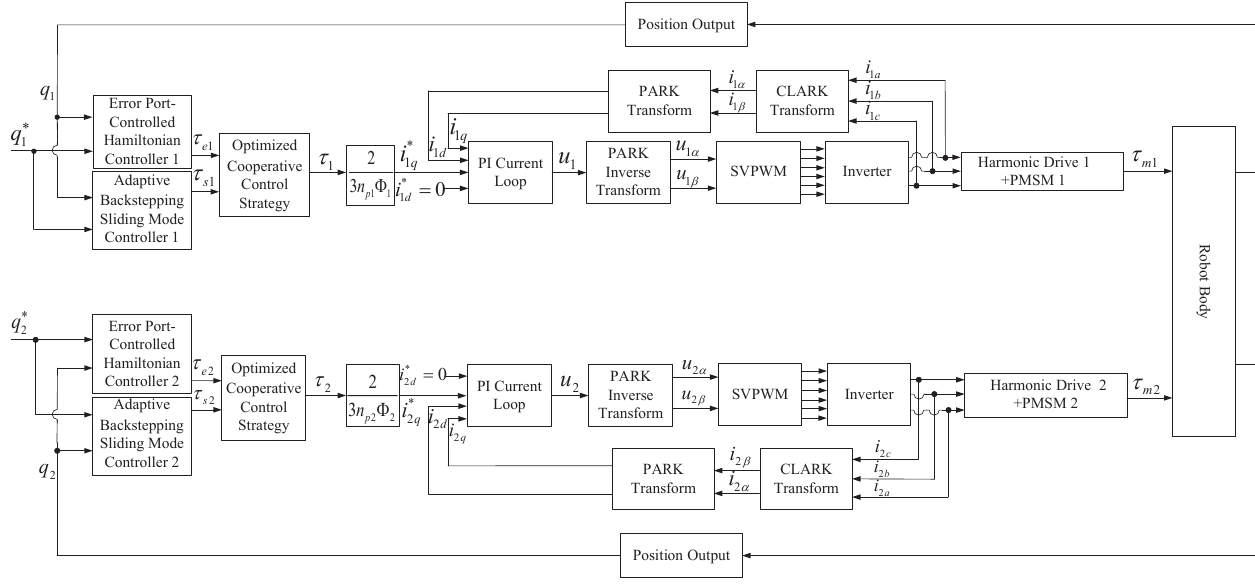
Figure 2. The control graph of optimized cooperative control of an EPCH energy controller and ABSM signal